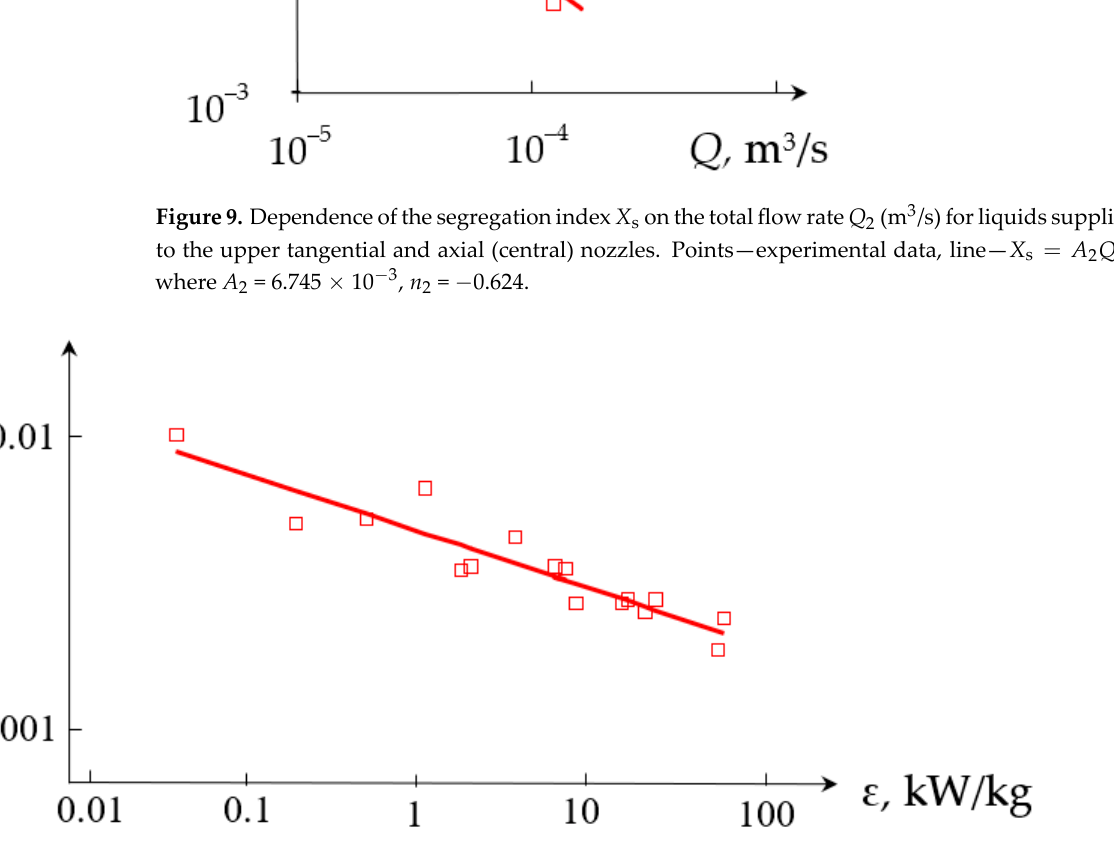
Figure 10. Dependence of the segregation index X s on the specific energy dissipation rate ε (kW/kg) for liquids supplied to the upper tangential and axial (central) nozzles. Points—experimental data, line— X s = A 3 ε n 3 , where A 3 = 4.618 × 10 − 3 , n 3 = − 0.21.